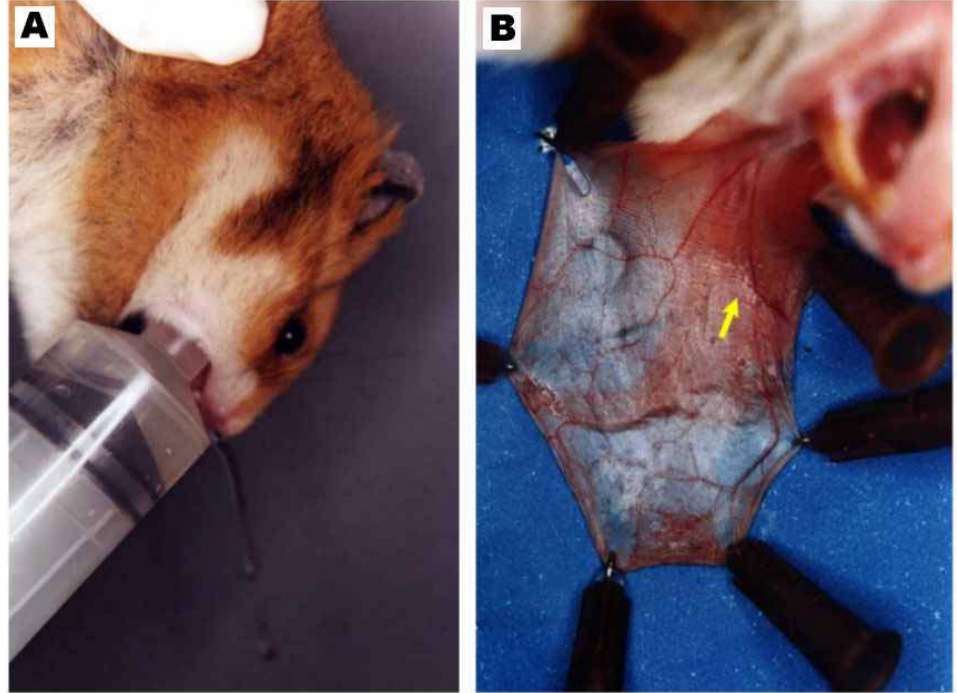
FIGURE 1 – Pre-surgical lavage and cheek pouch operating presentation